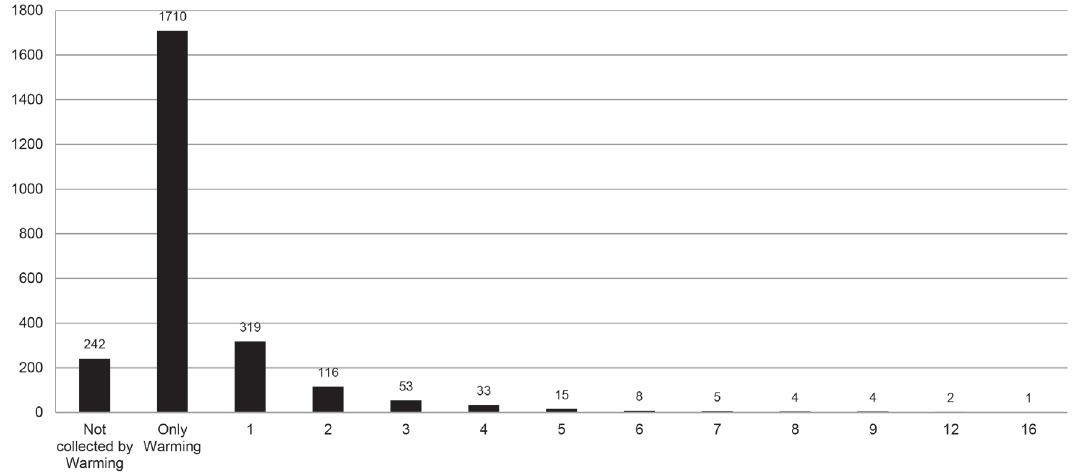
Figure 1 – Number of species of flowering plants recorded from Lagoa Santa, Minas Gerais, Brazil, including Warming’s Florula Lagoensis (1908) revised list and herbarium data, separated per frequency of collection. From left to right: the first bar shows the number of species not collected by Warming; the second bar shows the total number of species only collected by Warming; the bars numbered from 1 to 16 representes the total number of species collected once after Warming (bar 1), twice after Warming (bar 2), three times after Warming (bar 3), and so